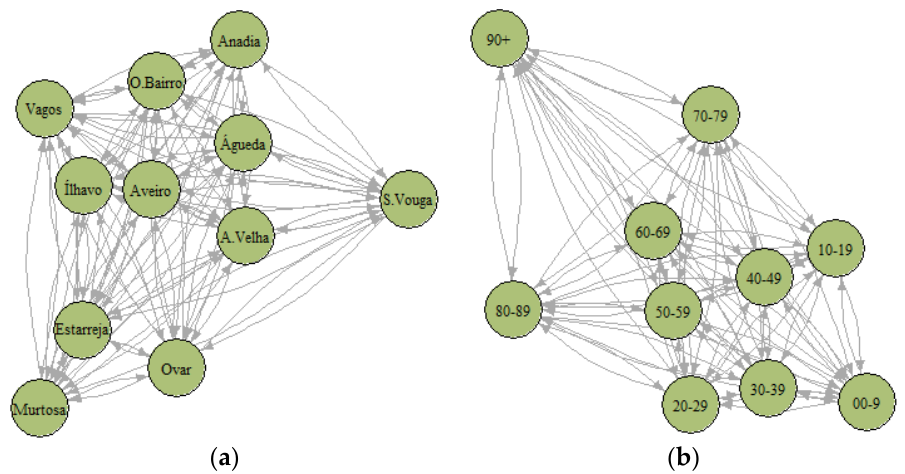
Figure 1. ( a ) Digraph of municipalities data regarding 2020 and 2021; and ( b ) digraph of age group data regarding 2020 and 2021.